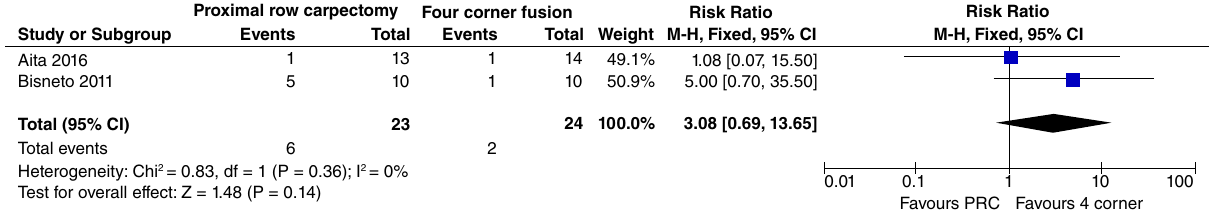
Figure 4. Forest plot of comparison: 1 Proximal row carpectomy vs Four corner fusion, outcome: adverse events.